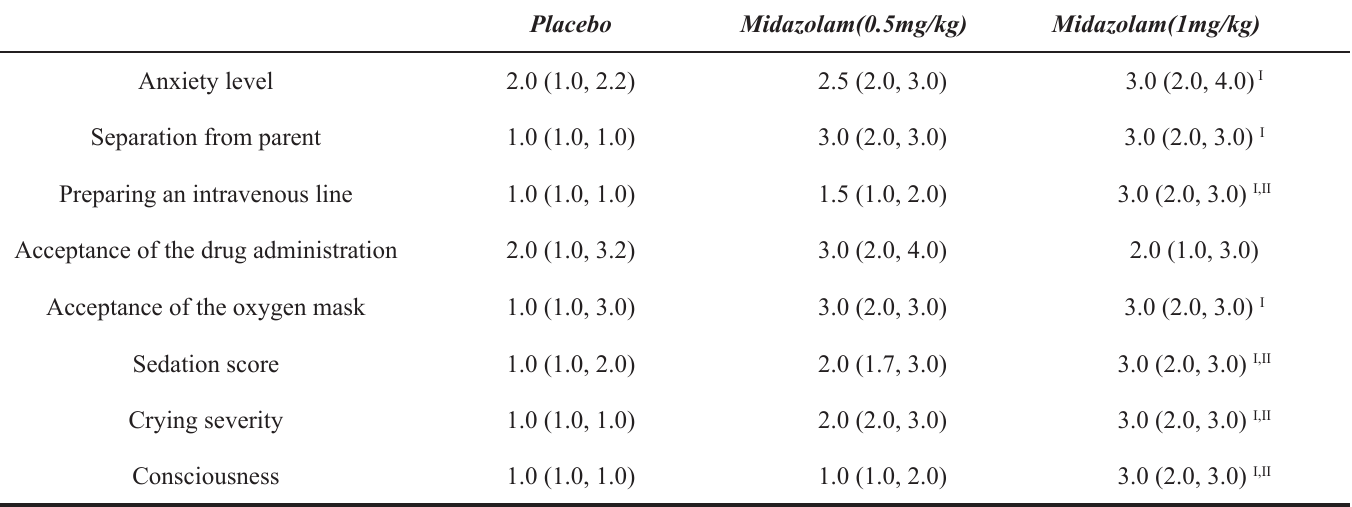
TABLE 3 - Data of behavioral scores of children allocated to receive with midazolam or placebo.